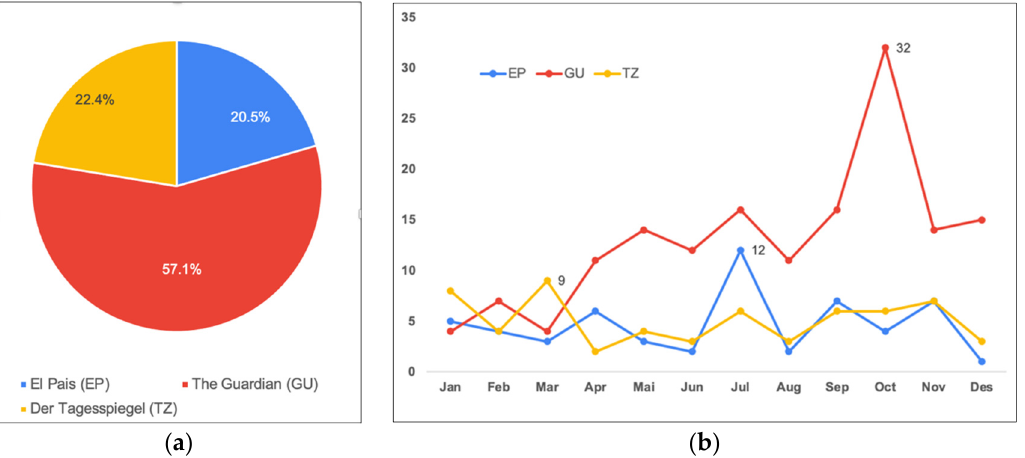
Figure 1. ( a ) Percentage of the sample published by each media outlet including ‘Climate change and meat’; ( b ) publishing distribution by month for each media.